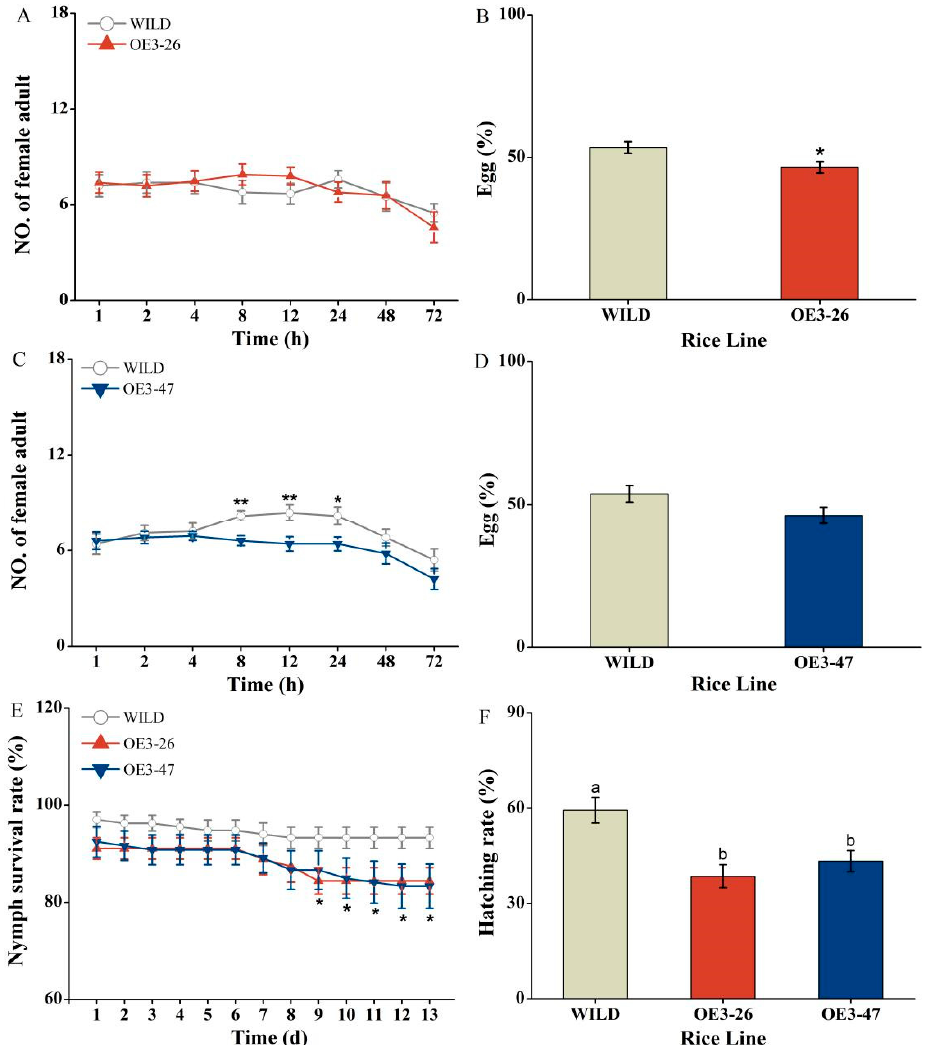
Figure 4. OsMKK3 positively mediates rice defense to BPH. ( A , C ) Number of gravid BPH females per plant (mean ± SE, n = 10) on pairs of plants (wild-type plants (WILD) versus mutant lines (OE3-26 and OE3-47 line)); ( B , D ) BPH egg percentage per plant (mean ± SE, n = 10) on pairs of plants (WILD versus OE3-26 or WILD versus OE3-47) after BPH infestation for 72 h. ( E ) BPH nymph survival rate (mean ± SE, n = 10) on WILD, OE3-26, and OE3-47 lines; ( F ) BPH hatching rate (mean ± SE, n = 15) on WILD, OE3-26, and OE3-47 lines. *(asterisk) shows significant di ff erences among WILD and oe-MKK3 (*, p < 0.05; and **, p < 0.01, Student’s t -tests); di ff erent letters represent significant di ff erences among WILD and oe-MKK3. (Duncan’s multiple range test, p <